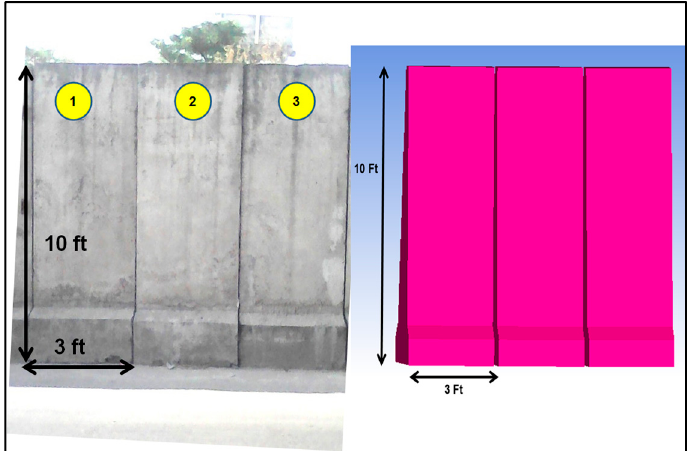
Figure 1. Blast protection wall panels.